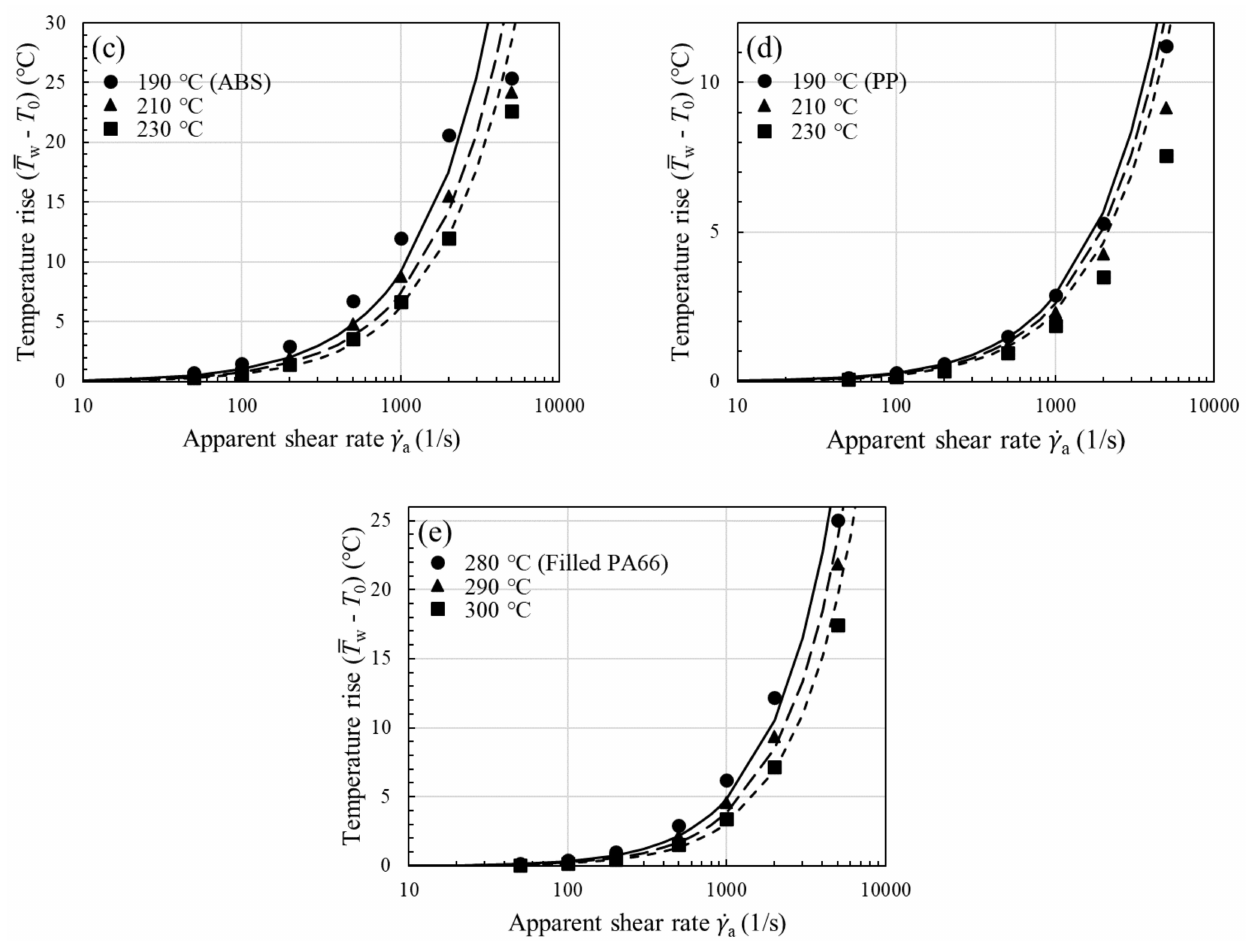
. γ a for ( a ) HIPS, ( b ) GPPS, ( c ) ABS, ( d ) PP, and